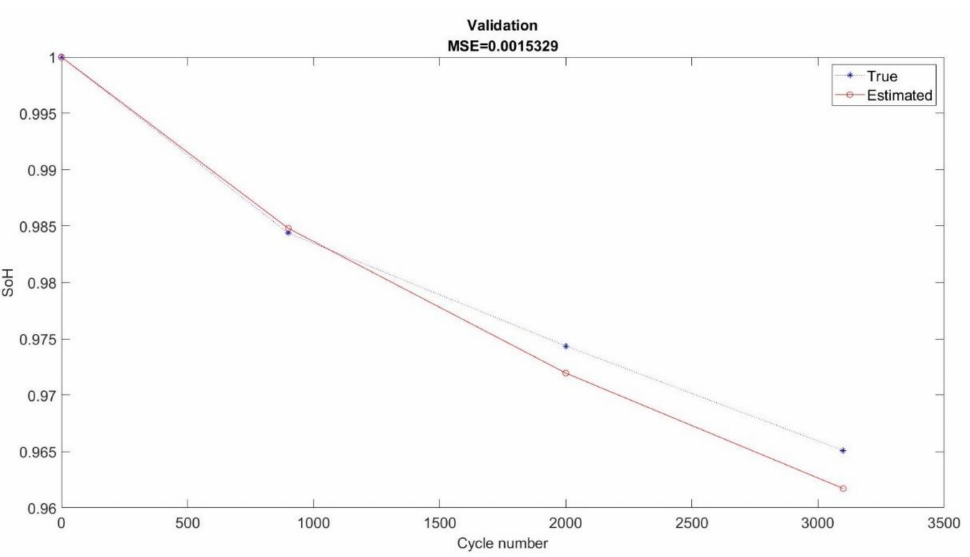
Figure 11. Validation for SoH estimation of cell No.